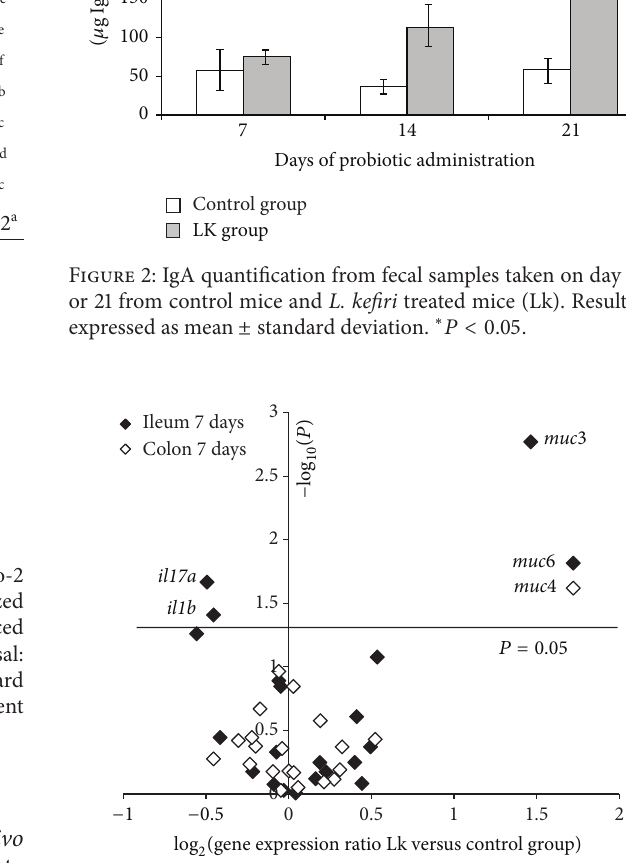
Figure 3: Gene expression ratio in ileum (black) and colon (white) of Lk group versus control group after 7 days of L. kefiri administra- tion. The x -axis of the plot represents log 2 relative expression level of thegeneandthe y -axisdisplaysthe − log 10 P (statisticalsignificance). The names of the genes which displayed significant differences are